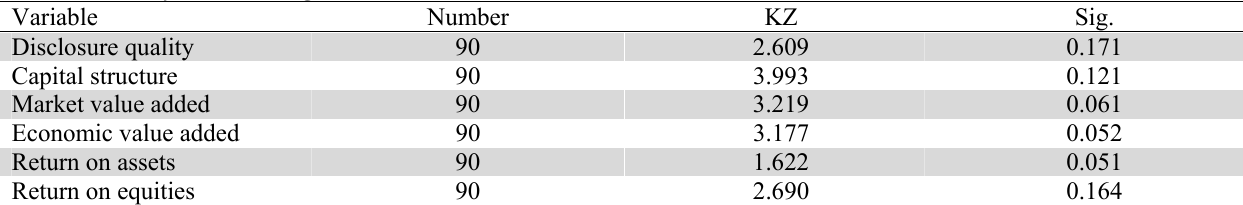
The summary of Kolmogorov-Smirnov